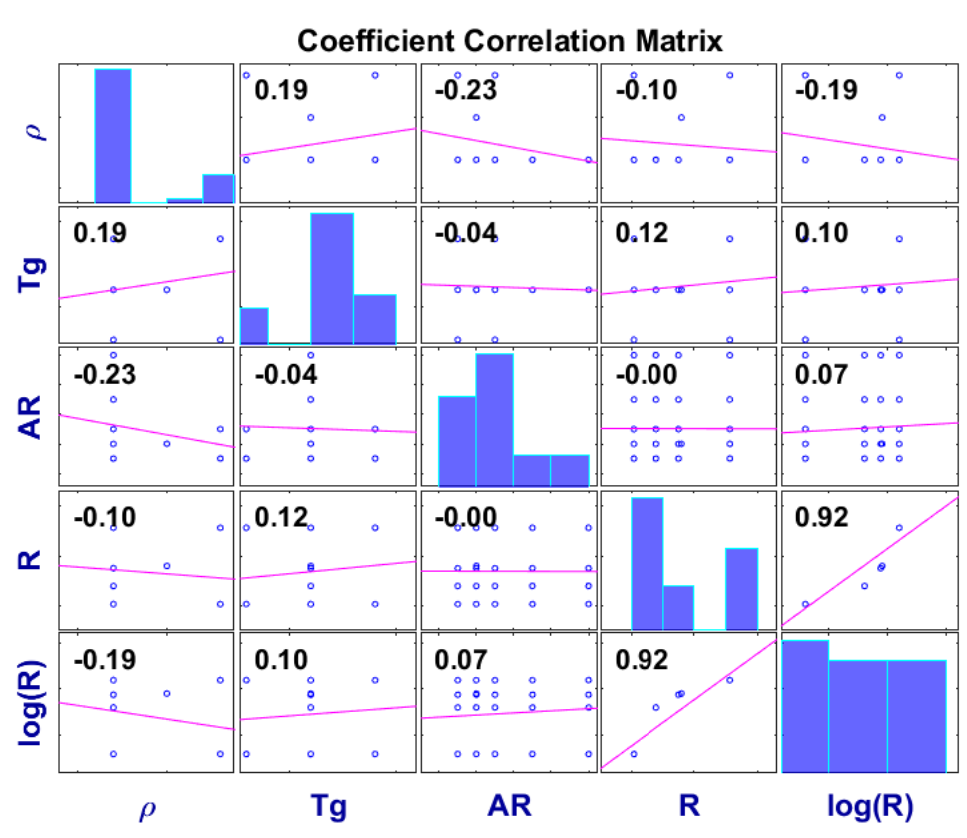
Figure 3. Correlation coefficient chart. Numbers give the r-values for the different correlations, dots show combinations of the input parameters constituting the data points, the magenta lines are the best straight lines through the dots, and the bars show the distribution for that specific input parameter. Correlation coefficient charts are used to illustrate if two input parameters or input and output parameters are correlated. Consequently, it can, among other things, be seen from a coefficient correlation chart whether the effect of the input parameters can be separated in the model, and it can be seen if the spans of the input parameters are represented